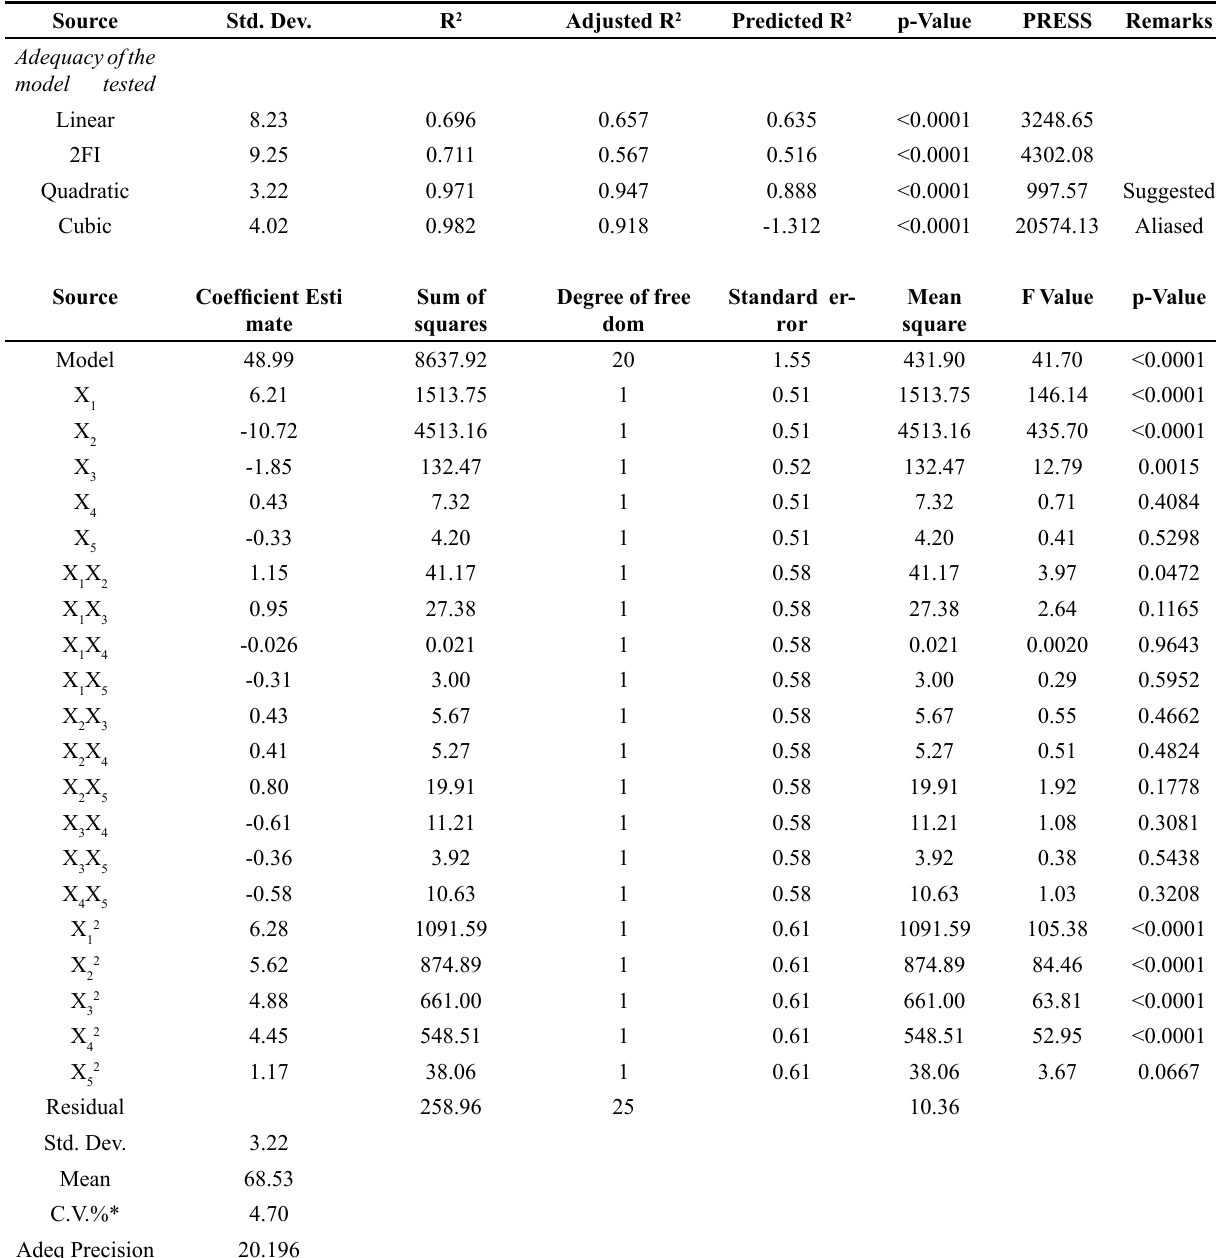
ANOVA analysis for the percentage of ash removal from